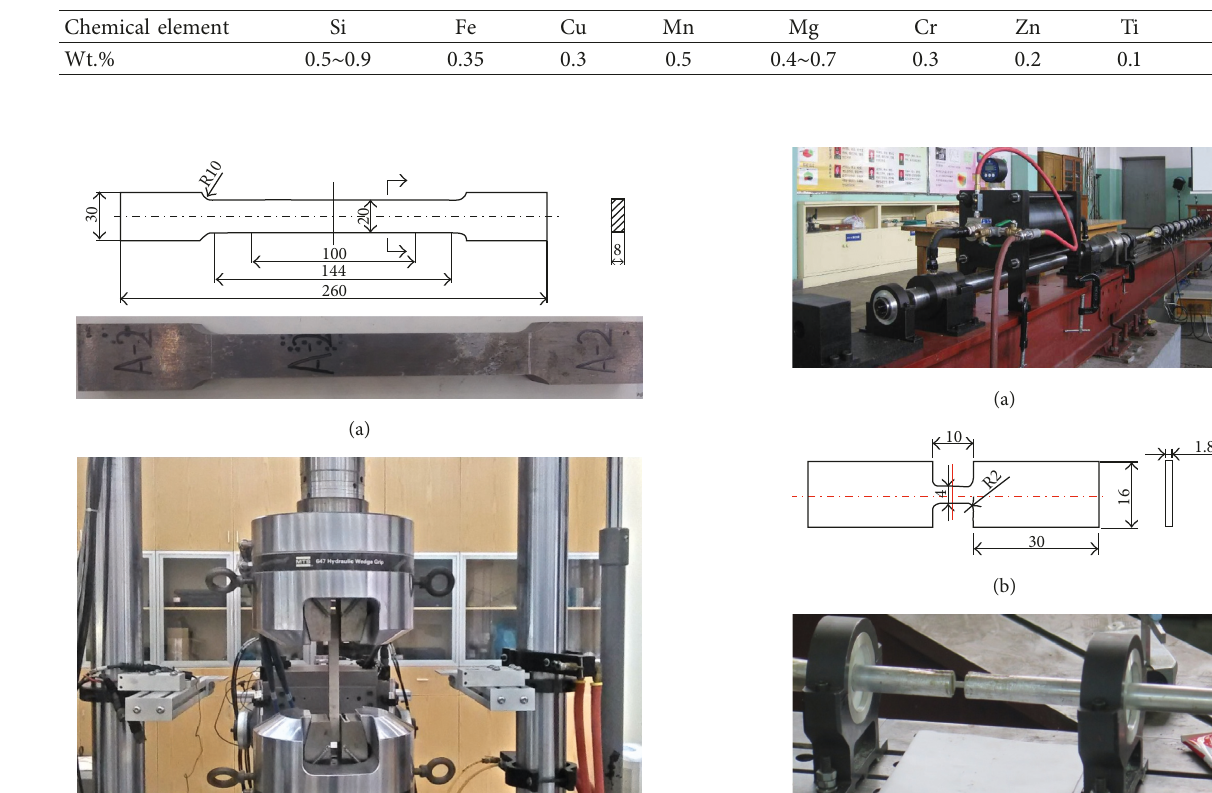
Table 1: The chemical composition of 6005 Al alloy.